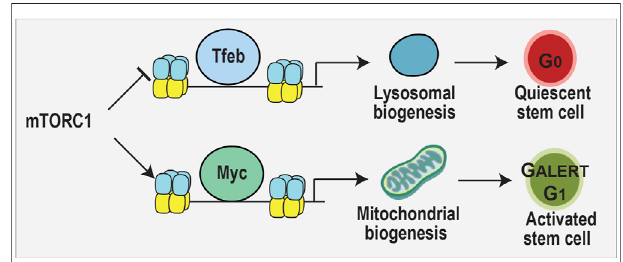
FIGURE 12 | Myc and Tfeb TFs compete for target sites in the genome. Myc induces mitochondrial biogenesis and stem cell activation. Tfeb promotes lysosomal biogenesis and stem cell dormancy. mTORC1 inhibits Tfeb function and promotes Myc activity during tissue regeneration, as shown in the hematopoietic